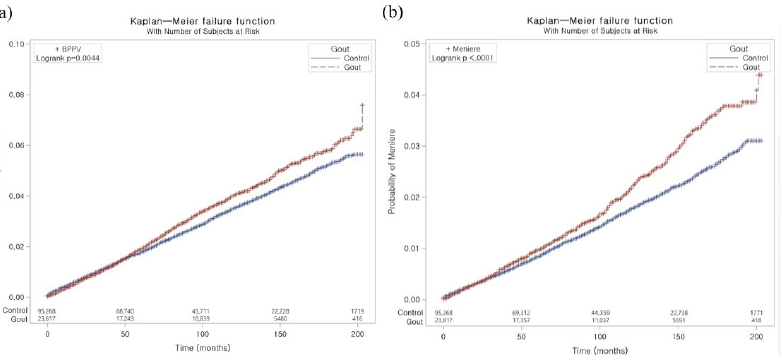
Figure 2. The Kaplan–Meier failure curve and cumulative incidence function for the occurrence of BPPV ( a ) and Meniere’s disease ( b